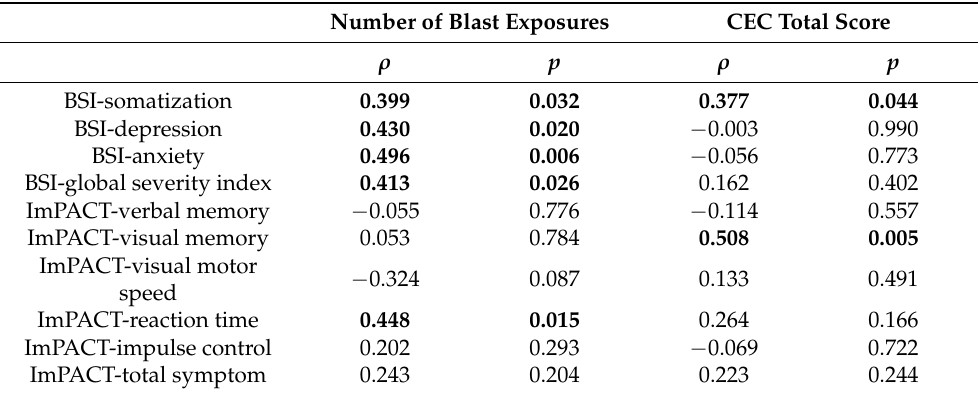
Table 3. Pearson Correlation Coefficients of Study